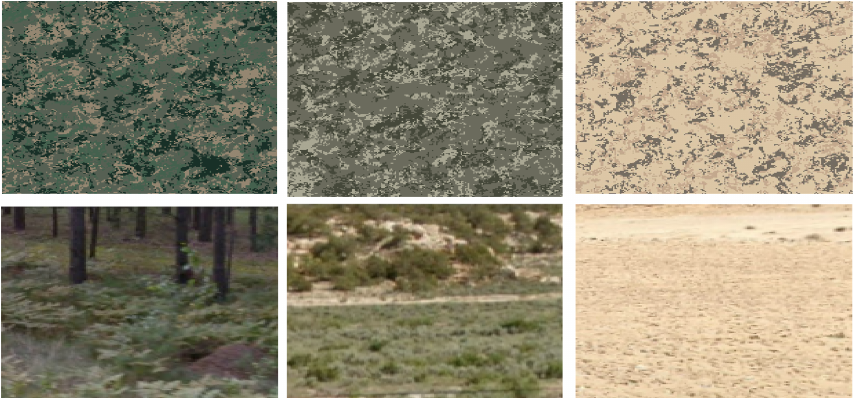
Figure 22. Camouflages generated by CammoGenerator application ( first row ) and the real terrains ( second row ) in forest terrain, steppe terrain, and desert